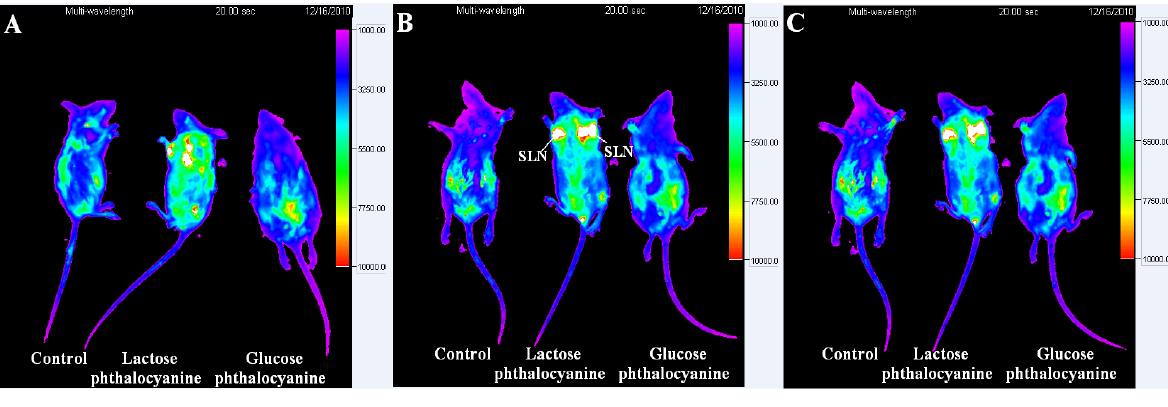
Figure 7. Optical imaging for SLN in vivo using saccharide-substituted zinc phthalocyanines as probes, with representative one of three in each group was given (injected with 100 µL of 200 µM with an exposure time of 20 s (filters: excitation 625 nm, emission 700 nm). ( A ) before administration; ( B ) after administration for 10 min; ( C ) after administration for 30 min.